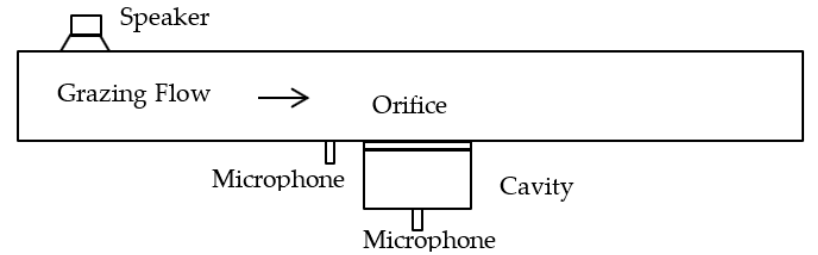
Figure 16. Schematic view of the test rig configuration in the experiment by Kabral [27].